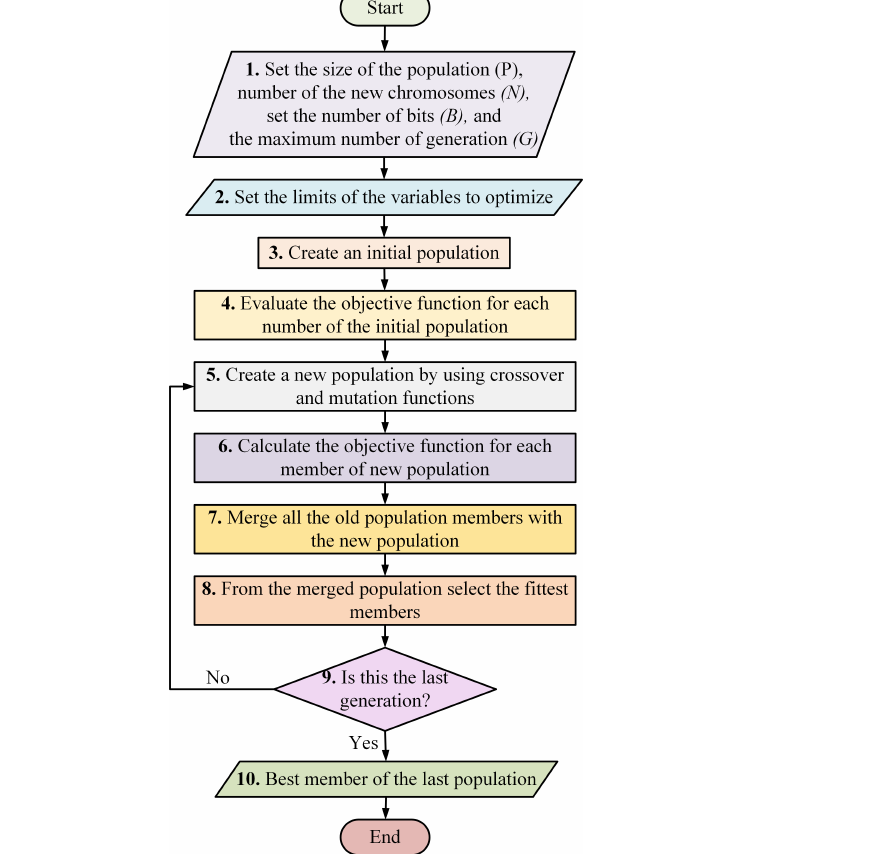
Figure 6. Flowchart of the genetic